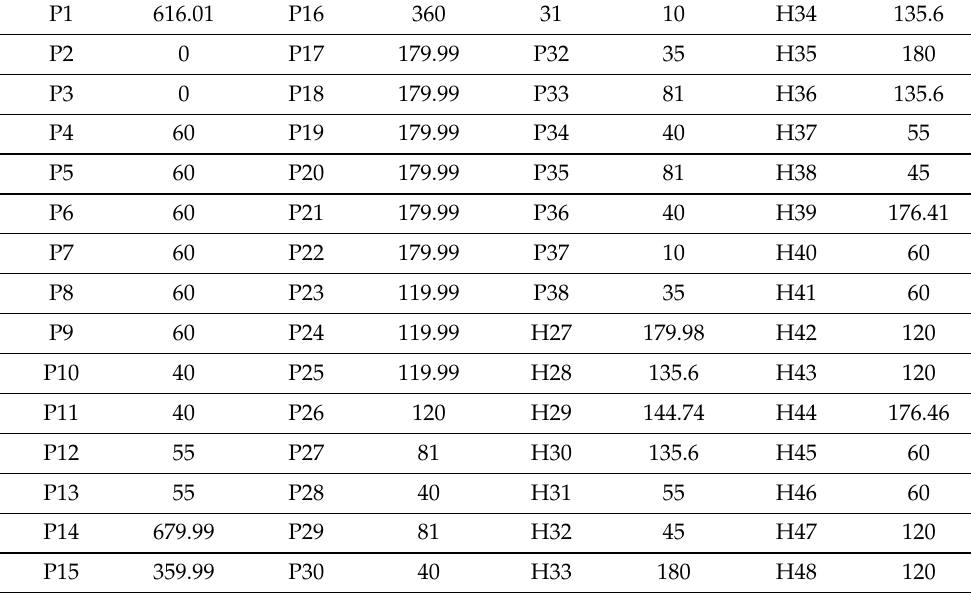
Table 12. Optimal schedule for the best cost obtained for Case study